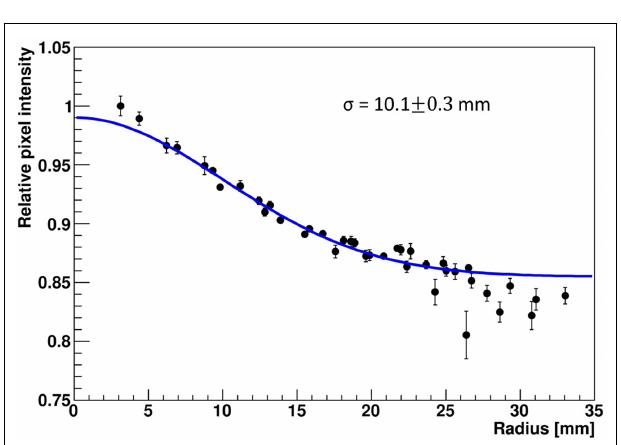
FIGURE 11 | Radial projection of the 2D light amplitude distribution derived from a central irradiation position of the reflectively wrapped LaBr 3 :Ce detector coupled to a 16 (cid:2) 16 multi-anode PMT . The blue curve represents a Gaussian fit to the data, the resulting width (cid:27) is indicated.